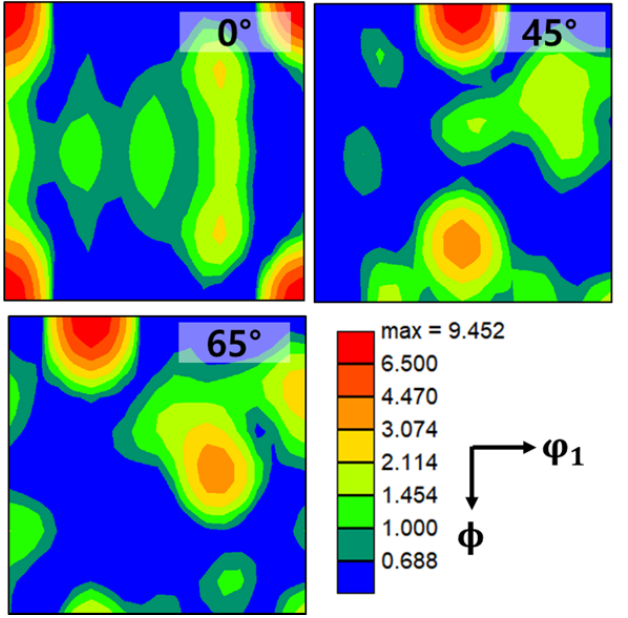
Figure 4. Orientation distribution function plot of recrystallized grains of the specimen annealed at 800 °C.